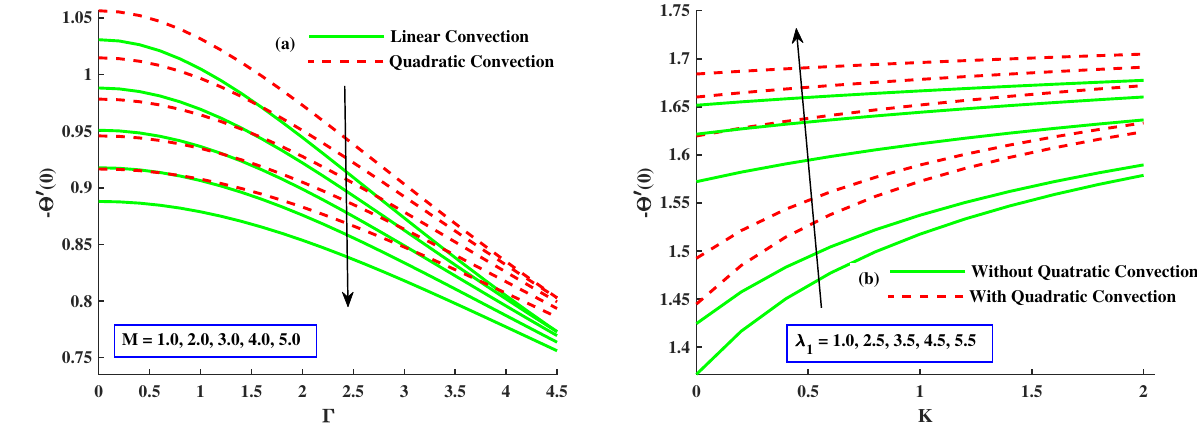
Figure 11. The influence of M , Γ , K , & λ 1 on the Nu x Re 0.5 x